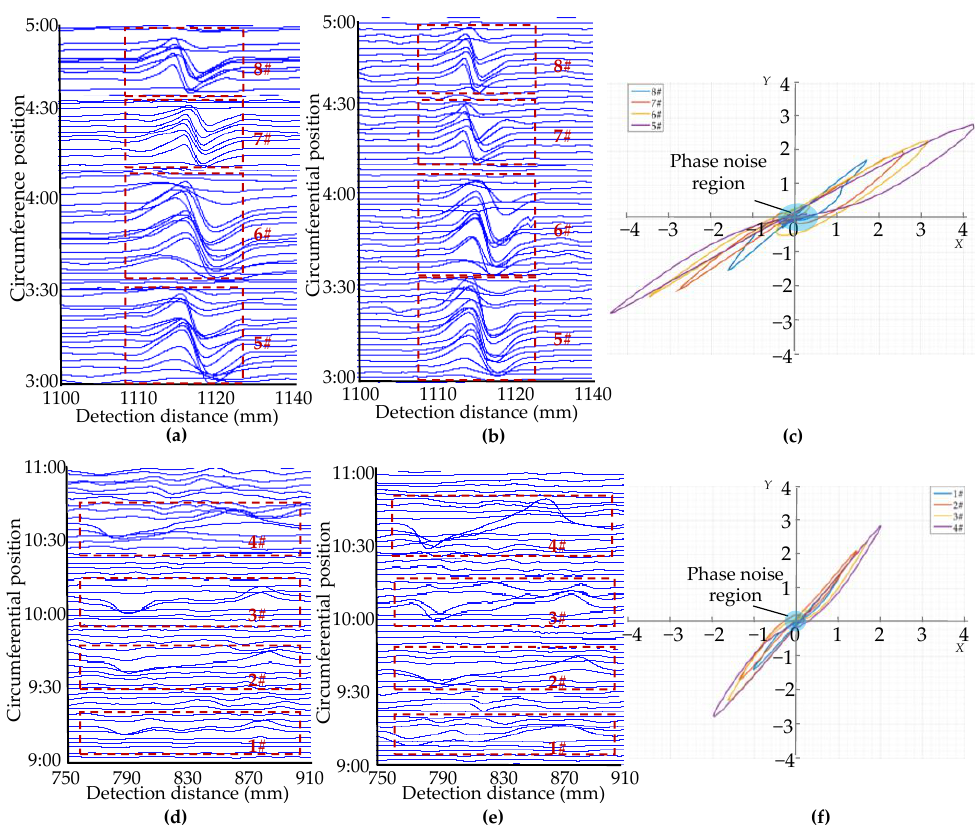
Figure 14. Results of crack pulling test: ( a ) In-phase components of the circumferential crack pulling test signals; ( b ) Orthogonal components of the circumferential crack pulling test signals; ( c ) Amplitude-phase composite figure for circumferential cracks; ( d ) In-phase components of the axial crack pulling test signals; ( e ) Orthogonal components of the axial crack pulling test signals; ( f ) Amplitude-phase composite figure for axial